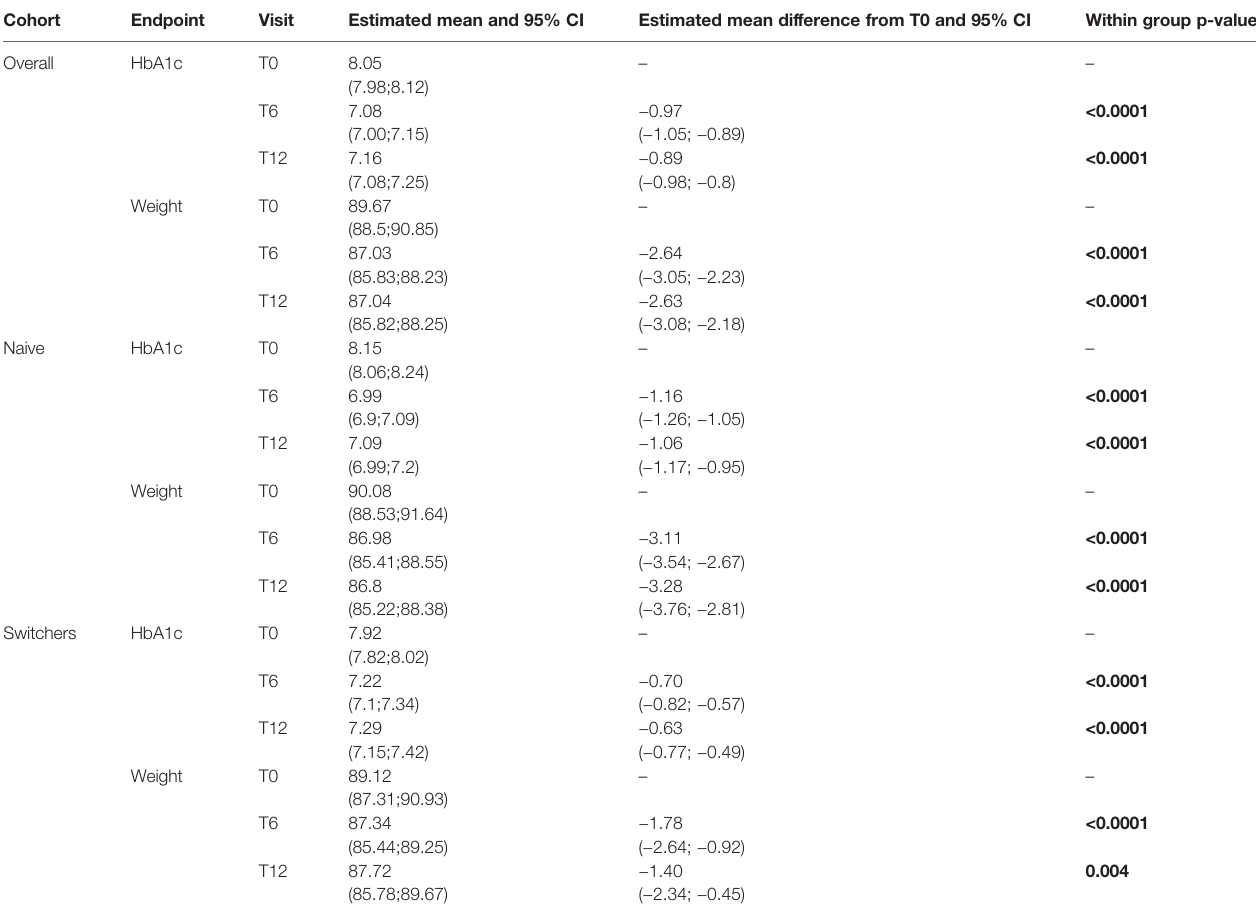
TABLE 2 | Changes in estimated mean levels of continuous endpoints during the follow-up by cohort and within-group group comparisons (T6 vs. T0 and T12 vs.